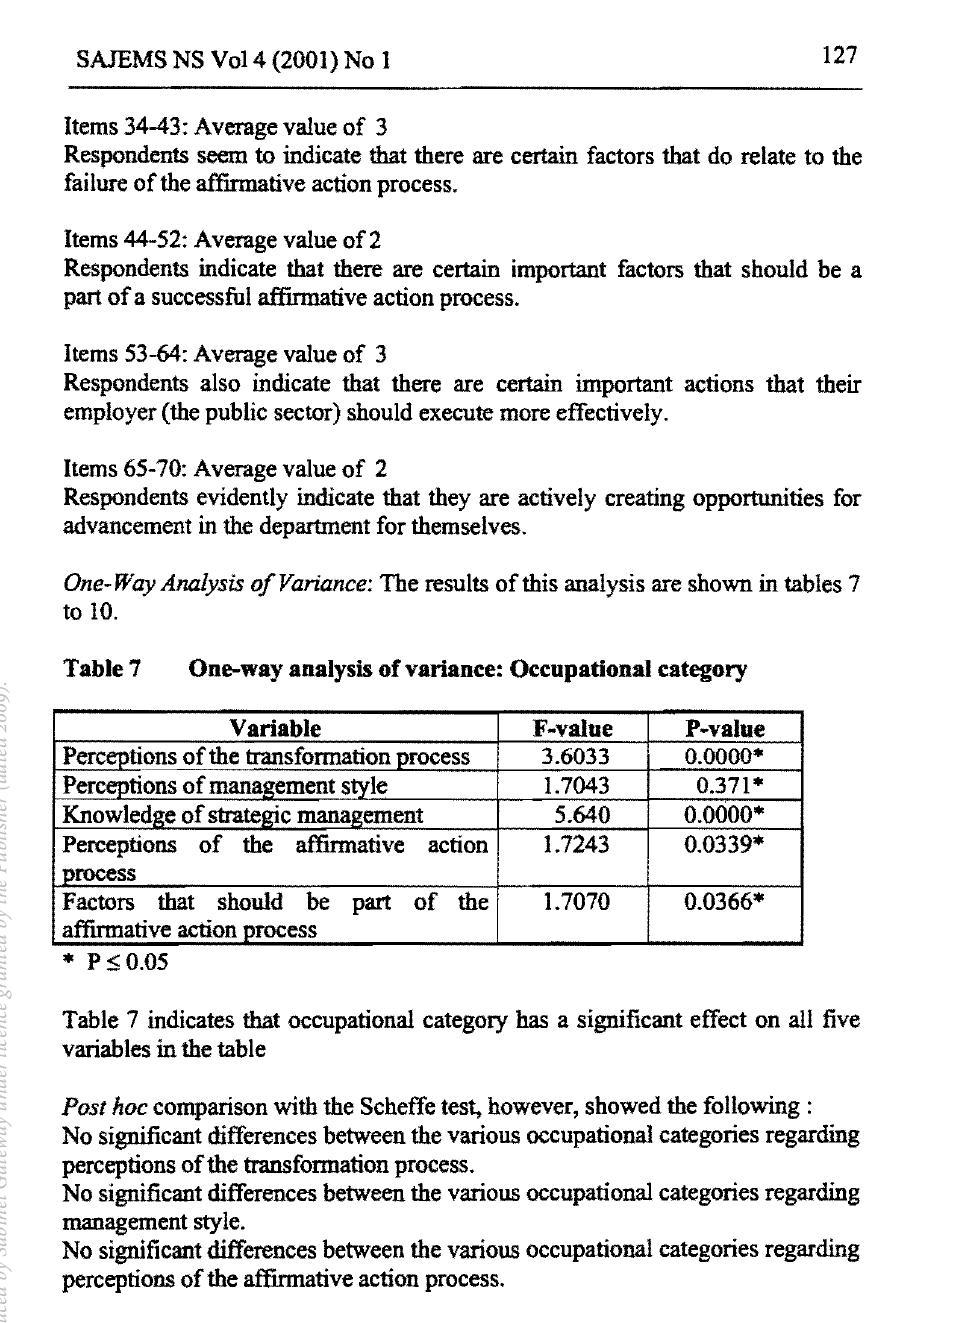
One-way analysis of variance: Occupational